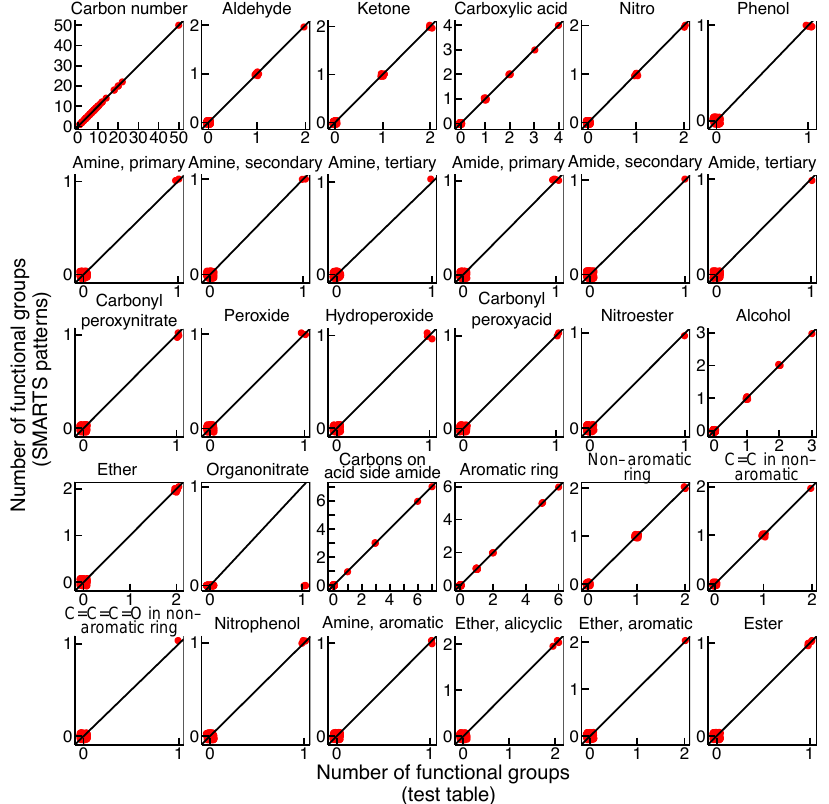
Figure 2. Validation of the developed chemoinformatic patterns for the chemical substructures required in the SIMPOL.1 model (Pankow and Asher, 2008). This validation set includes 99 compounds as described in Sect. 2.